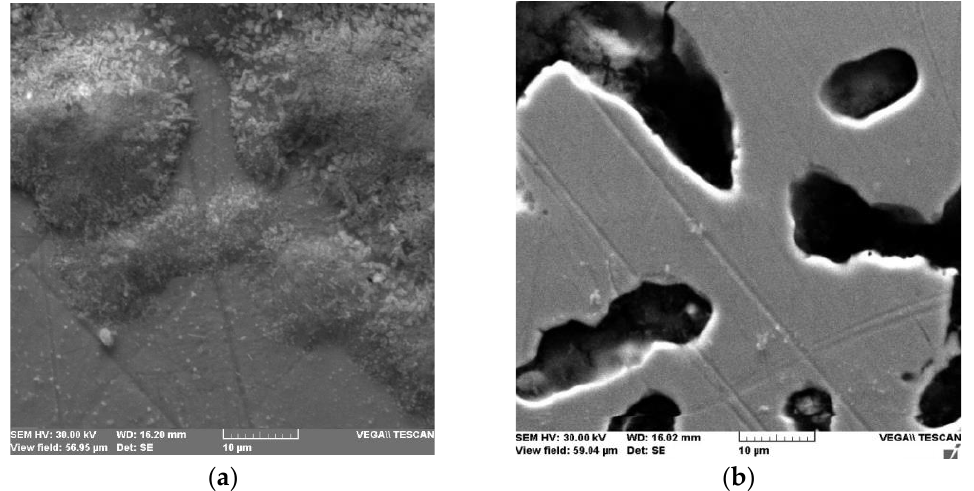
Figure 3. ( a ) Surface appearance of corroded Cr-Co alloy; ( b ) Ni-Cr skeleton affected by corrosion. (WD — working distance — the distance between sample surface and the lower end of the pole piece where the electrons are coming from; HV — accelerated energy; SE — detector).